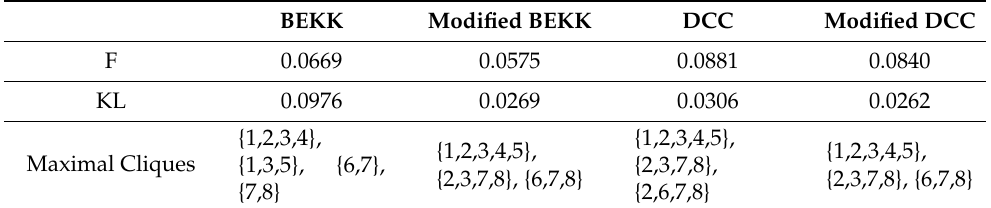
Table 5. Values of the Frobenius and the Kullback–Leibler loss functions and the maximal cliques: case N = 8 and δ = 0.5.